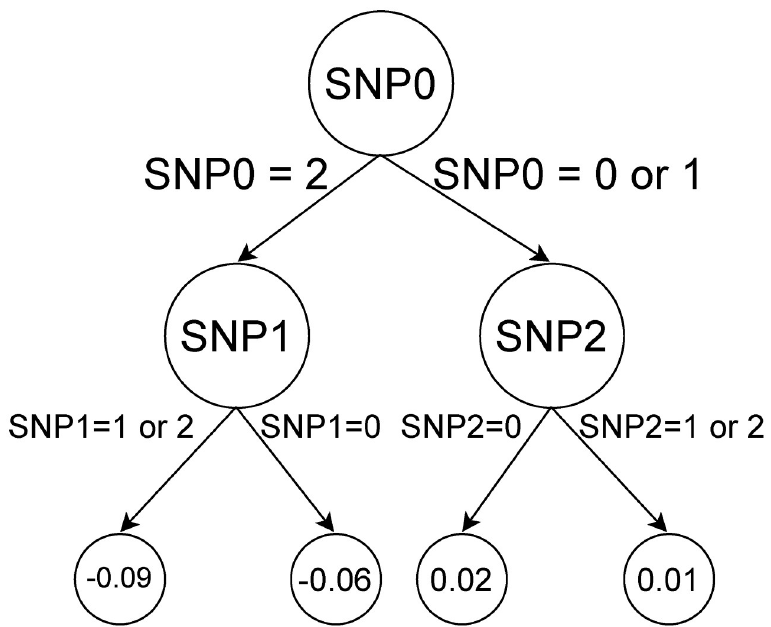
Fig 1. Example of a depth-2 decision tree that uses three different SNPs. Leaf nodes represent the weights that these particular SNP values contribute to the value of final prediction for a single datapoint. The genotypes are encoded as 0: homozygous reference, 1: heterozygote, 2: homozygous alternative.